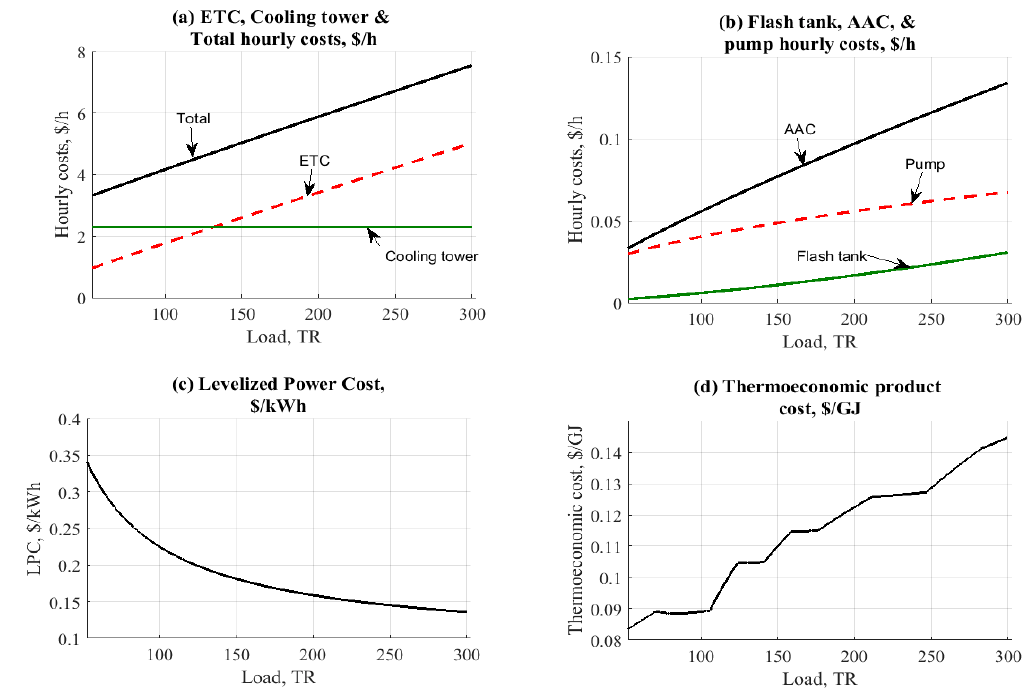
Figure 9. Data results based on the effect of cooling load.